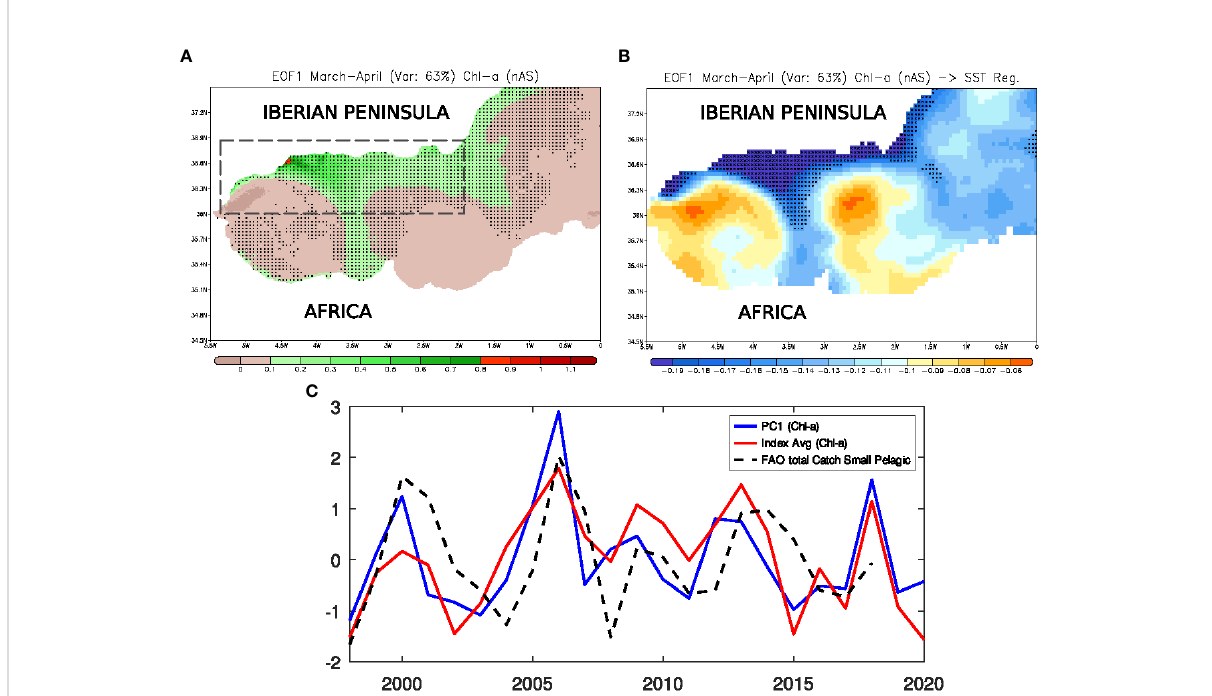
FIGURE 2 (A) Regression map of the leading empirical orthogonal function (EOF) of monthly Chl-a anomalies averaged in March – April and calculated over the nAS (see dashed box) onto the same Ch-a anomalies over the whole Alboran Sea (units in mg/m 3 per standard deviation of PC1). (B) Regression map of the Chl-a leading mode onto the SST anomalies averaged in March – April (units in degrees per standard deviation of PC1). (C) Principal component (PC1) associated with the Ch-a leading mode in March – April over the nAS (blue line), evolution of Ch-a anomalies averaged in January – April over the nAS (red line), and annually and spatially averaged catches of small pelagic species within the nAS (dashed black line). Black points indicate areas where the response is signi fi cant (p-values less than 0.02) according to a bootstrap analysis with replacement (with 500 bootstrap